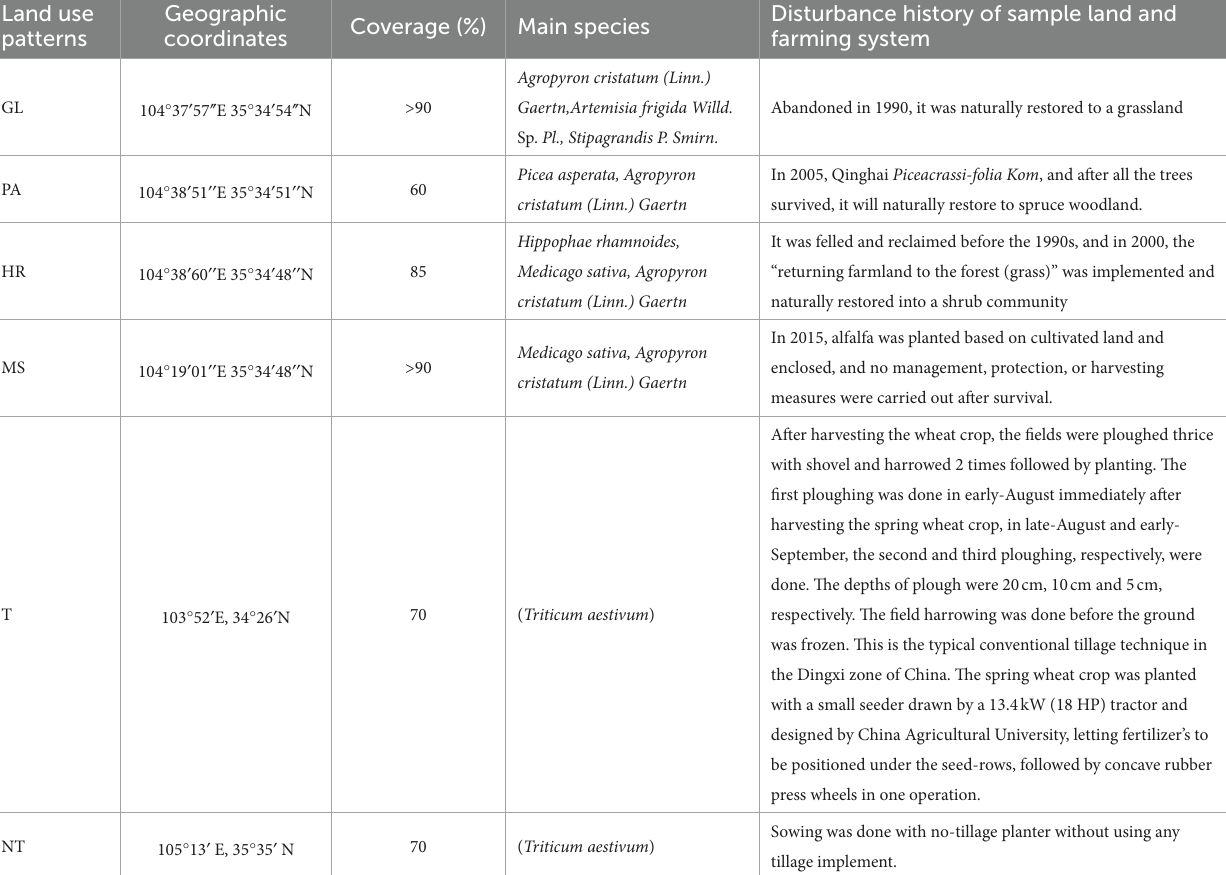
TABLE 1 Basic information on different land types. Land use Geographic patterns